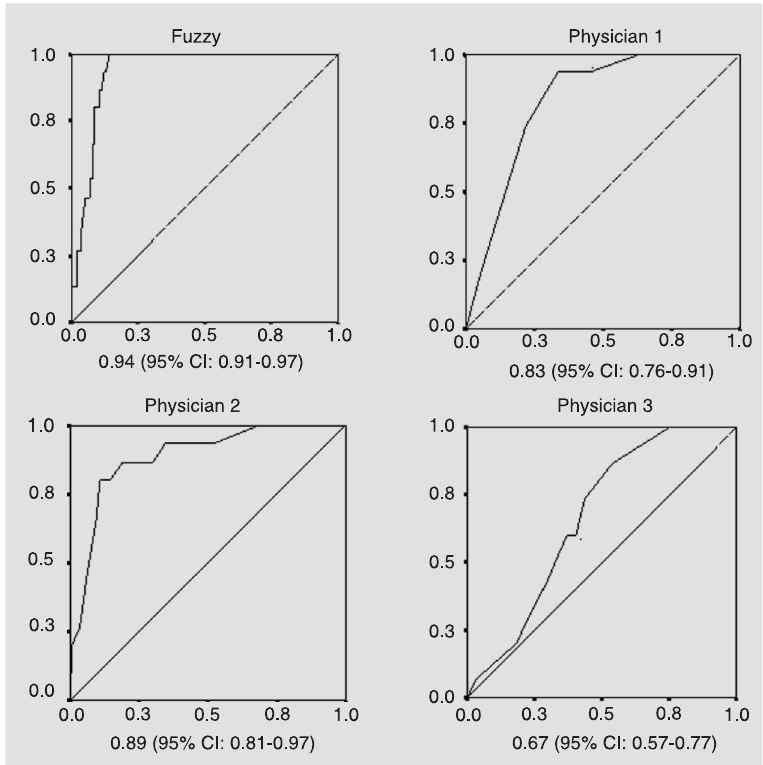
Figure 4. ROC curves for fuzzy score and physicians. The x-axis is 1 minus the specificity (the false-positive rate) and the y-axis is the sensitivity (the true-positive rate). The diagonal line on the graph from (0,0) in the lower left hand corner to (1,1) in the upper right hand corner reflects the characteristics of a test with no discriminating power. Below each graphical are shown the area under the ROC curve and the respective 95% confidence interval (CI).